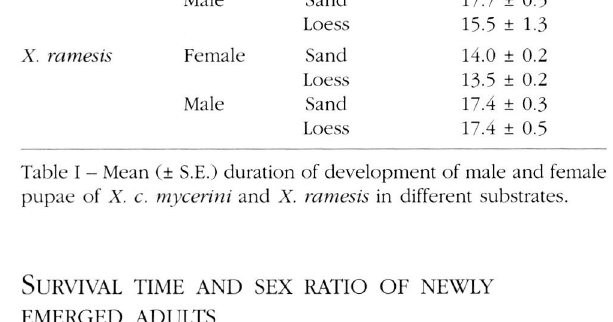
SURVIVAL TIME AND SEX RATIO OF NEWLY